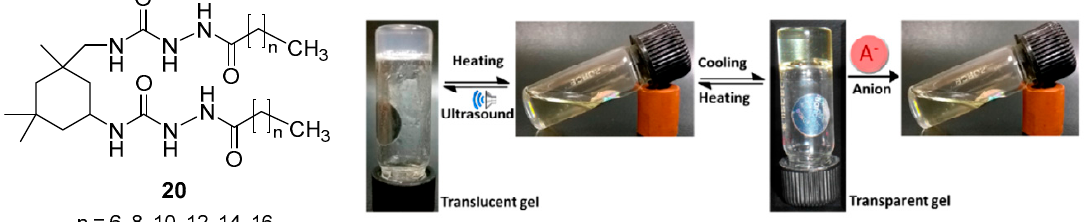
Figure 14. Structure of cyclohexane-based bis(acyl-semicarbazide) gelators 20 and photograph of the multiple switching process of the C 12 -organogellator under the alternate effects of ultrasound, temperature and anions. Adapted with permission from ACS [45].